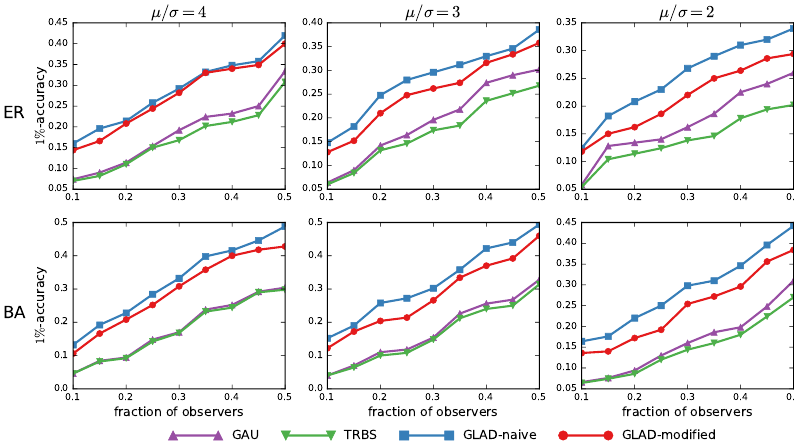
Figure 3. γ %-accuracy of different source localization algorithms on synthetic trees. Because the number of nodes is 100, this figure corresponds to a case in which the estimated source is also the real